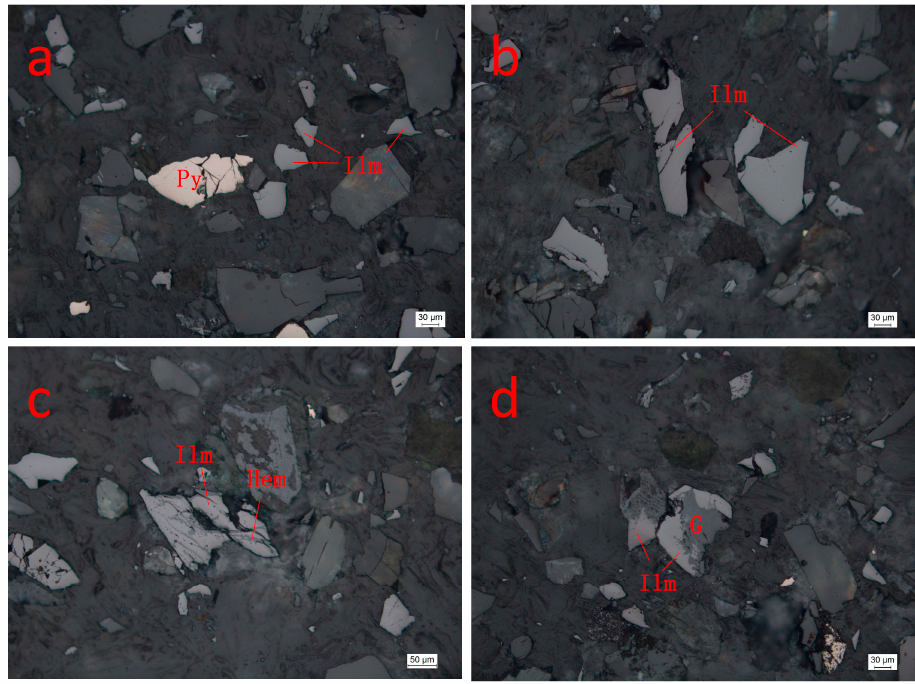
Figure 3. Optical micrographs of raw ilmenite ore samples: ( a ) liberated grains of ilmenite with little pyrite; ( b ) liberated grains of ilmenite; ( c ) ilmenite closely linked with hematite; ( d ) ilmenite closely linked with other gangues (Ilm: ilmenite; Hem: hematite; Py: pyrite; G: gangue).